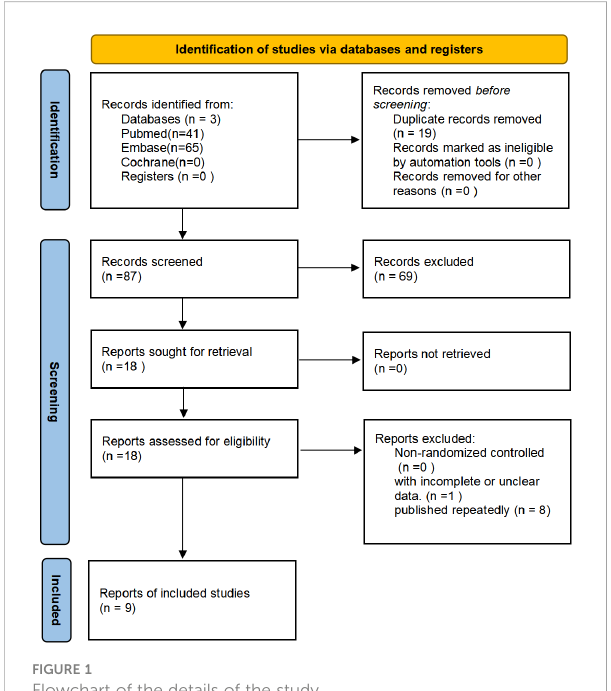
FIGURE 1 Flowchart of the details of the